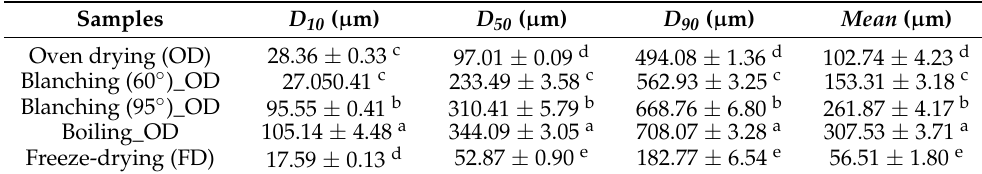
Figure 3. ( a ) Particle size distribution curves and ( b ) cumulative undersize curves of potato flour samples prepared under different processing conditions. Table 5. Particle size parameters of potato flour samples.